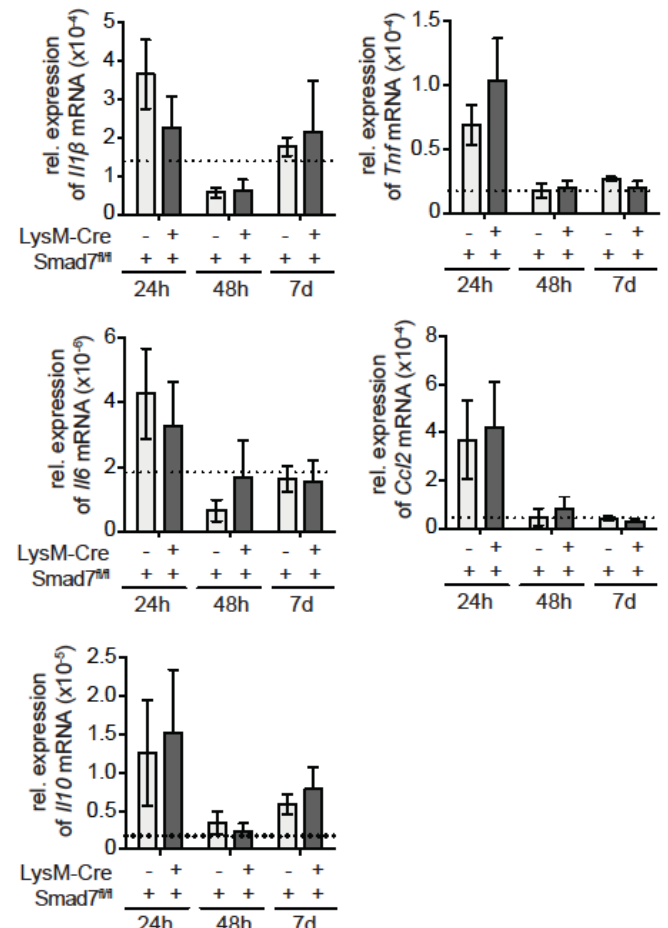
Figure 3. Inflammatory gene expression in LysM-Cre Smad7 fl / fl after CCl 4 injection. The 8- to 10-week-old Smad7 fl / fl and LysM-Cre Smad7 fl / fl littermates were injected with 30% CCl 4 in corn oil and sacrificed at the indicated time points. As a control, mice were left untreated. At the indicated times, liver samples were taken for quantitative real-time PCR for pro- ( Il1b , Tnf , Ifng , Il6 , Ccl2 ) and anti-inflammatory ( Il10 ) genes. Relative mRNA expression levels of target genes are depicted calculated in relation to the expression of the reference gene mRNA by the ∆ Ct method. The dotted line indicates expression in non-treated control animals. Data shown are representative of three independent experiments with three to five animals per group. Error bars indicate mean ± SEM. Statistical significance was calculated by ANOVA, but no significant p -values ( ≤ 0.05) between LysM-Cre pos and Cre neg Smad7 fl / fl were present in these data.